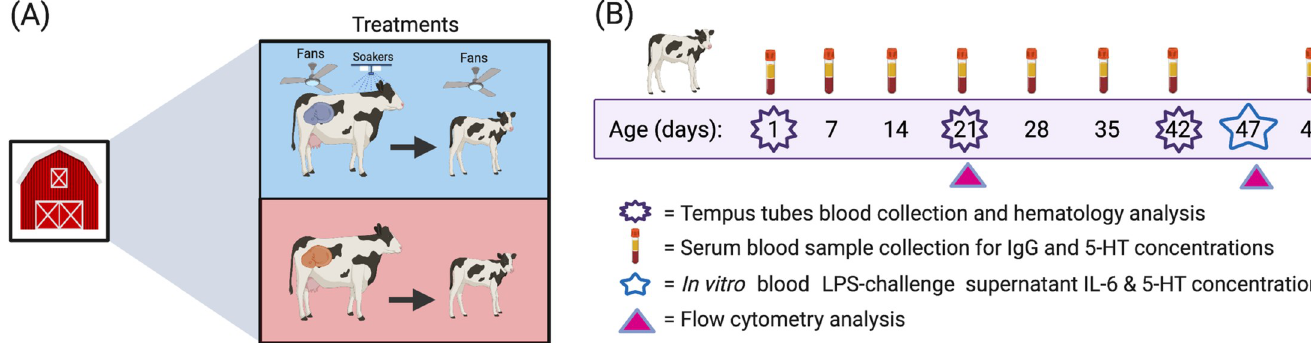
Fig 1. Overview of experimental design, timeline, and sampling schedule. ( A ) Dairy calves were gestated by dams exposed to heat stress (access to the shade of a free- stall barn, indicated by the red rectangle) or heat stress abatement (access to shade plus fans and water soakers, indicated by the blue rectangle) during late-gestation (~last 46 d, June-August 2018). After birth, calves were raised under similar environmental conditions to their dams until weaning (56 d of age), resulting in two treatments: heat stress ( HS , n = 6) or cooling ( CL, n = 6) across the pre- and postnatal periods (~ 102 d). ( B ) Blood was collected weekly from d 1 to d 49 to assess serotonin and IgG concentrations. On d 1, 21, and 42, blood was collected using Tempus RNA tubes for gene expression analysis and tubes with K 2 EDTA anticoagulant for blood hematology analysis. On d 21 and 47, blood was collected using sodium heparin tubes for flow cytometric analyses, and an on d 47 to perform an in vitro LPS- stimulation